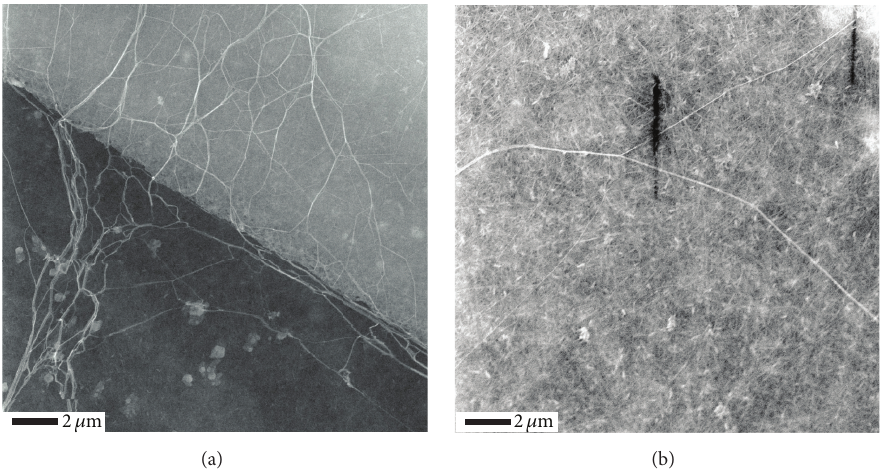
Figure 7: Scanning electron microscopy images of long BC fibers synthesized for 3 days under RMF exposition.